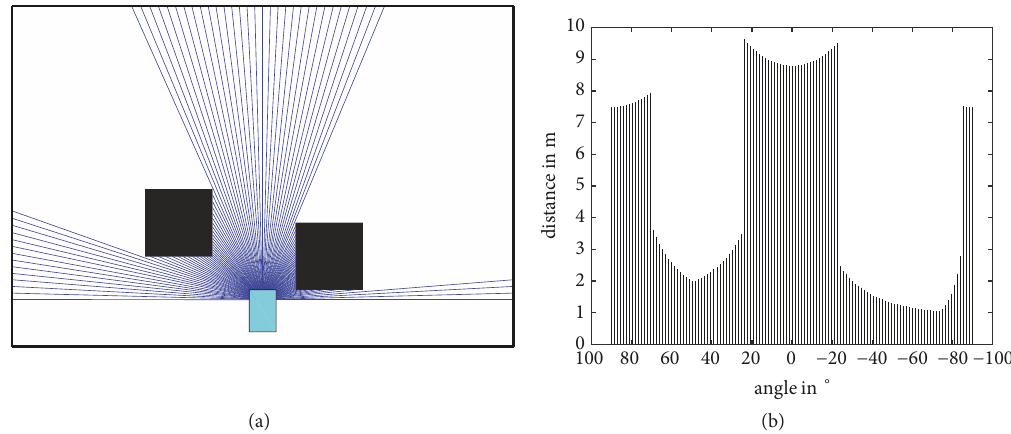
Figure 1: (a) Illustration of the laser range finder and (b) corresponding sensor data (distance versus